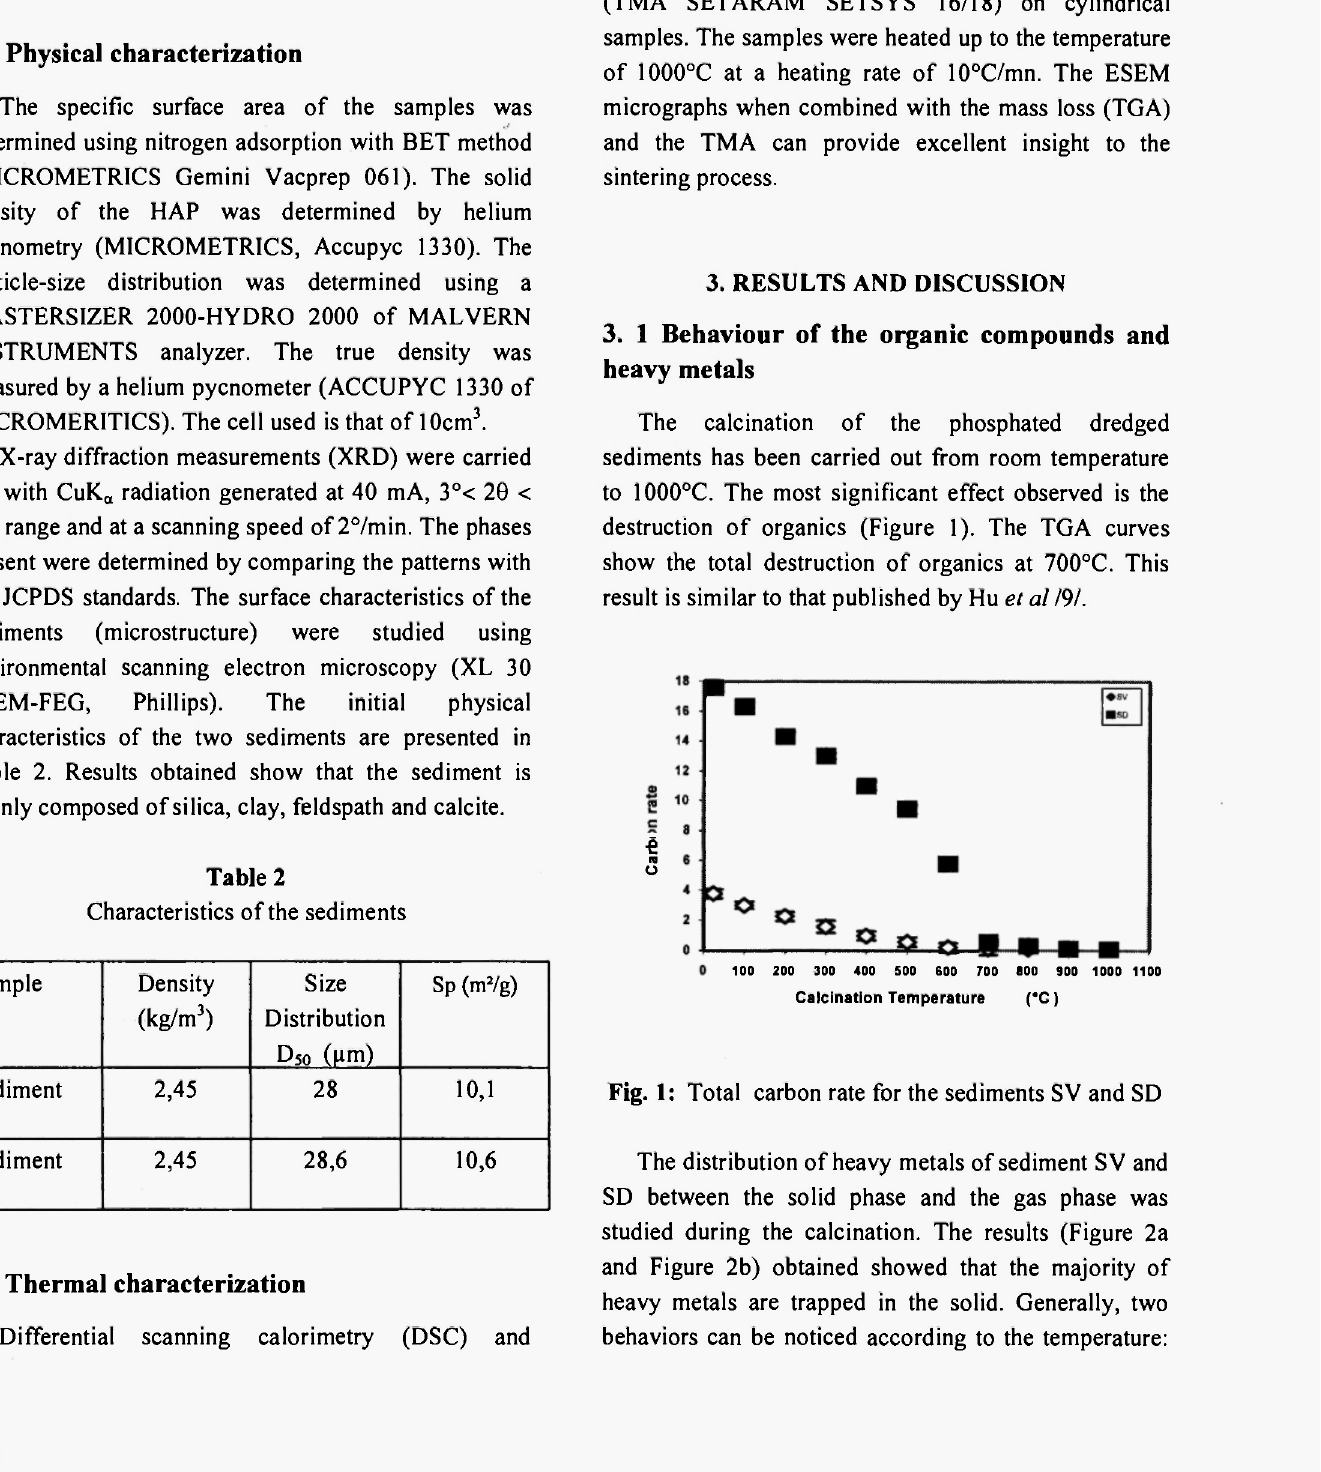
Fig. 1 : Total carbon rate for the sediments SV and